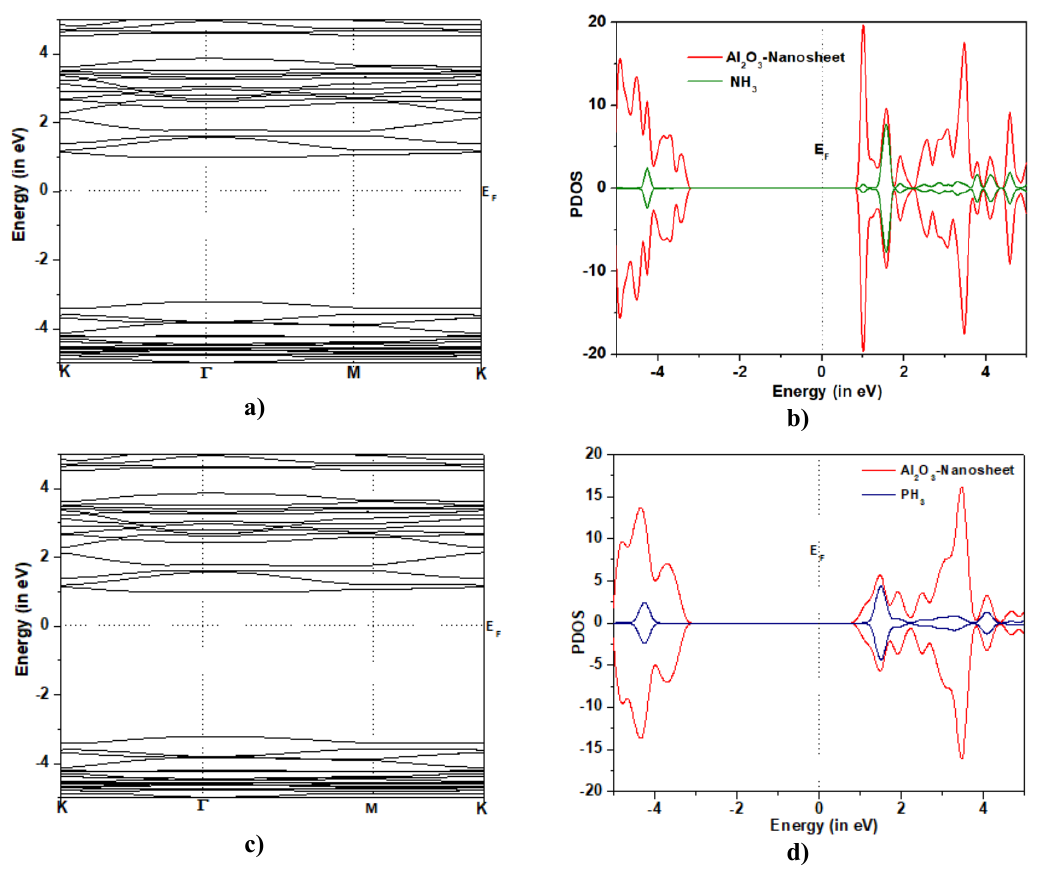
Figure. 5. Bandstructure and PDOS of a) NH